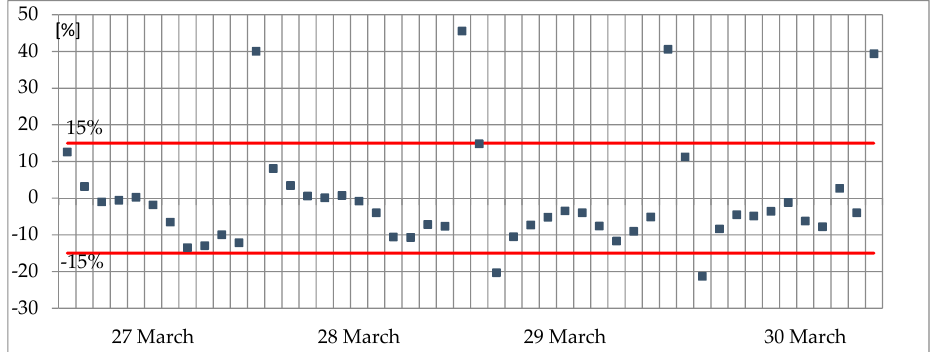
Figure 3. Trend of the percentage error for the clear sky days forecast.